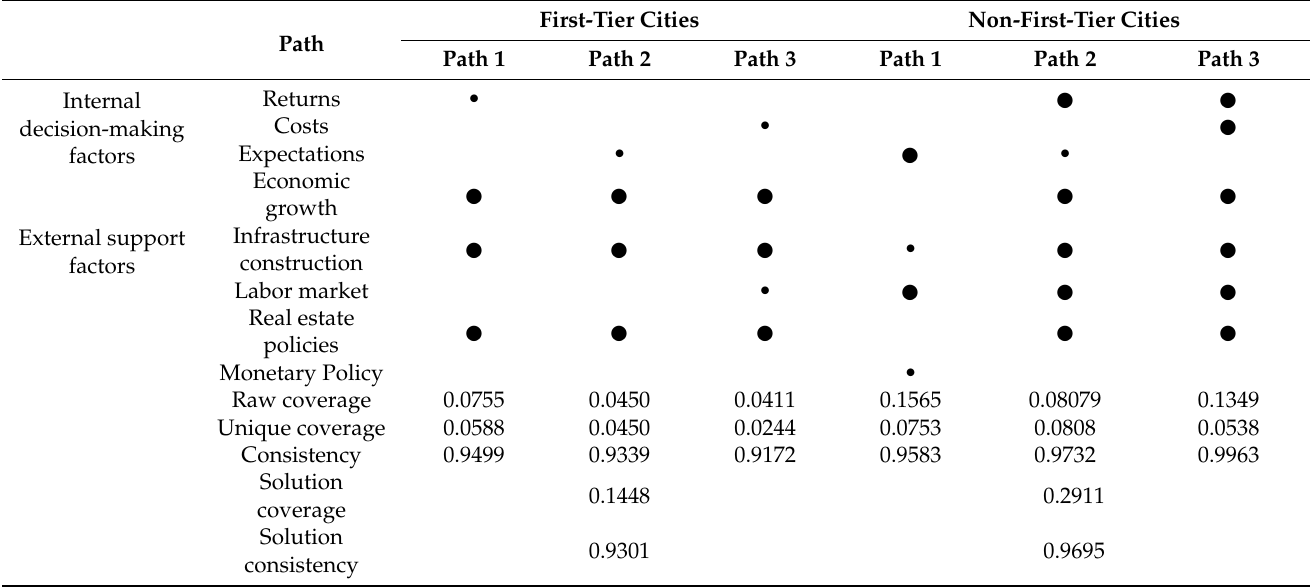
Table 5. Robustness tests for varying calibration